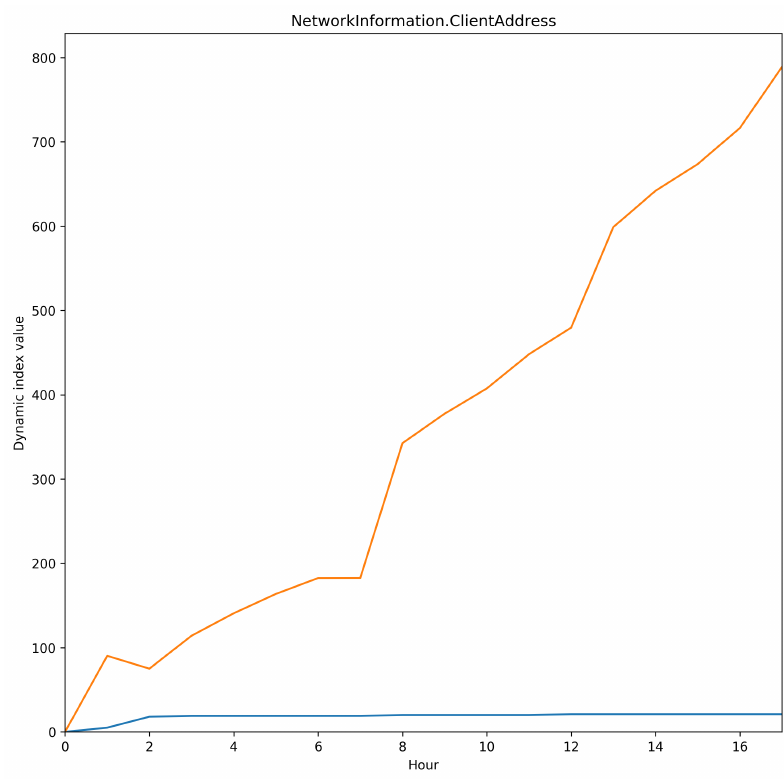
Figure 3. Dynamic indexes for the NetworkInformation.ClientAddress event